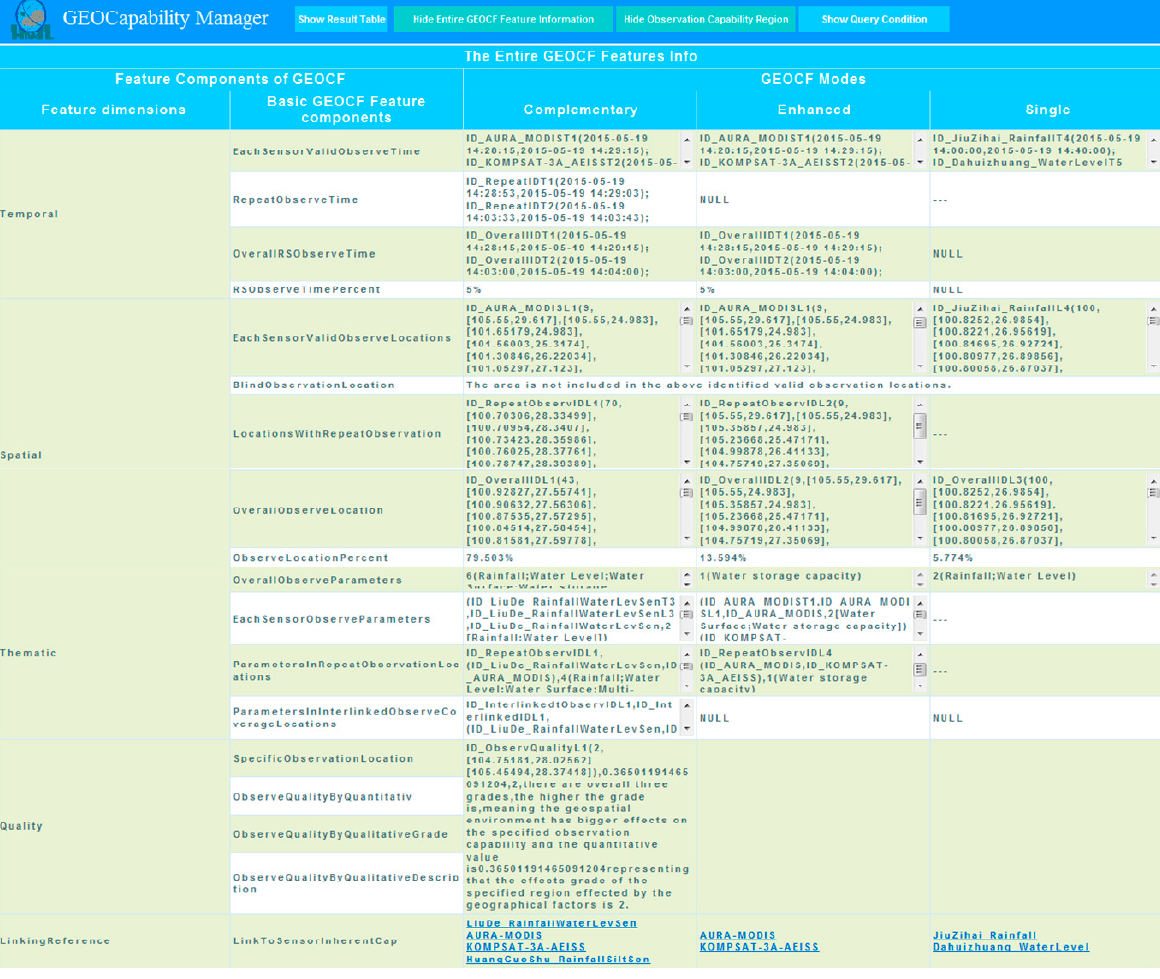
Figure 13. A sample table representing all GEOCF feature components. This is an instance of Table 1.